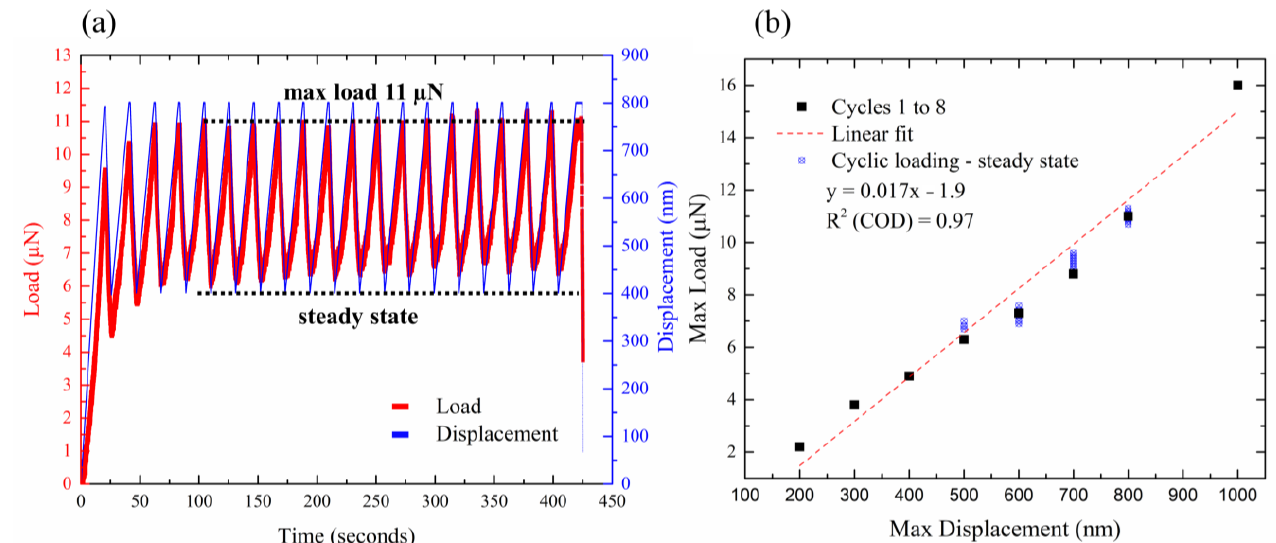
Figure 4. ( a ) Load–time–displacement curves of a representative cyclic compression loading experi- ment, consisting of 20 deformation cycles to a displacement of 800 nm and then retracting to 400 nm. The loading curve shows an increase in values in the initial four cycles followed by a steady state, where the maximum and minimum loads hardly change between the cycles. ( b ) Maximum load vs. max displacement curve—comparison between the maximum load values in the steady state to the maximum load values in the initial eight cycles of the previous experiment. The blue circles represent the cyclic loading steady state, and the black rectangles represent the eight cycles from Figure 2b. The CNT mechanical response is highly